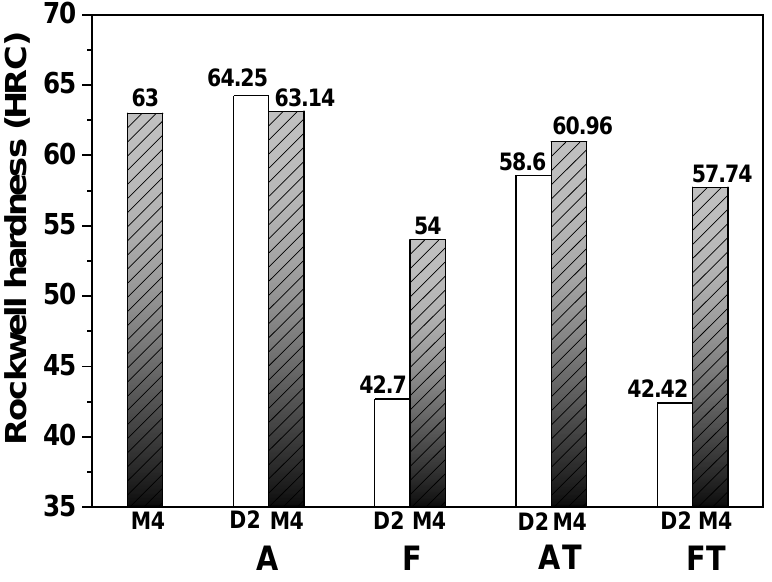
Figure 7. Rockwell hardness of the post-heat treated M4.